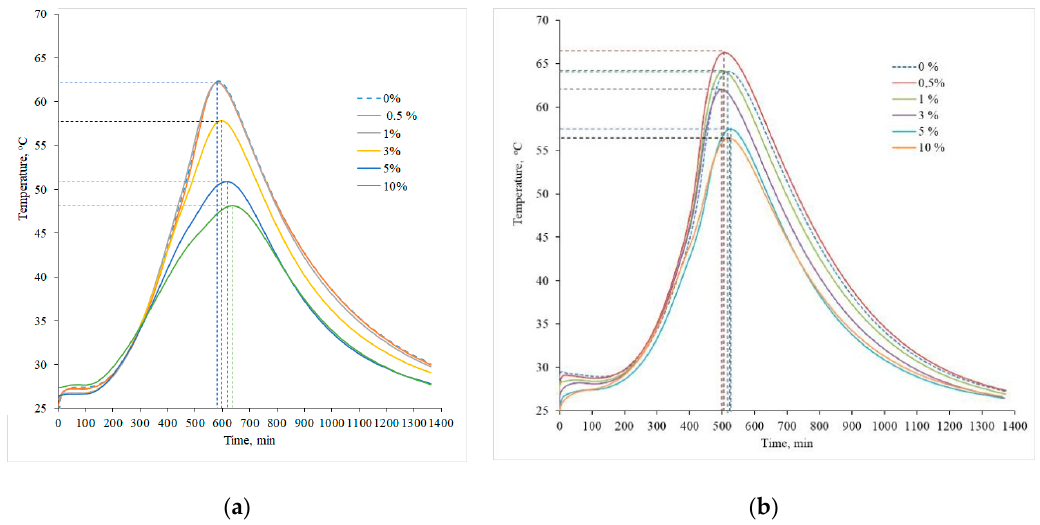
Figure 3. Effect of zeolitic by-product on hydration temperature of Portland cement pastes containing different amounts of